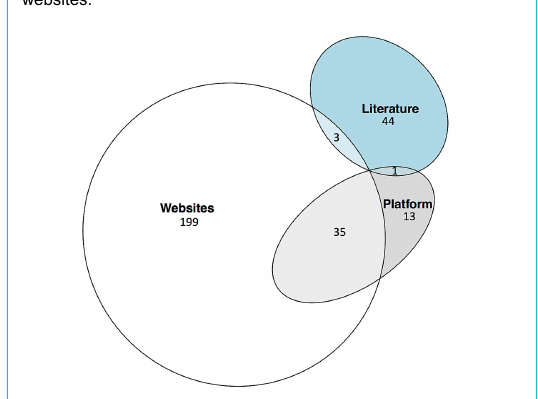
Figure 2: Sources of the guidelines included in the review.Litera- ture – scientific literature databases and archives of two major non-indexed Swiss medical journals, Platform – FMH guidelines platform guidelines.fmh.ch, Websites – Swiss medical societies’ websites.